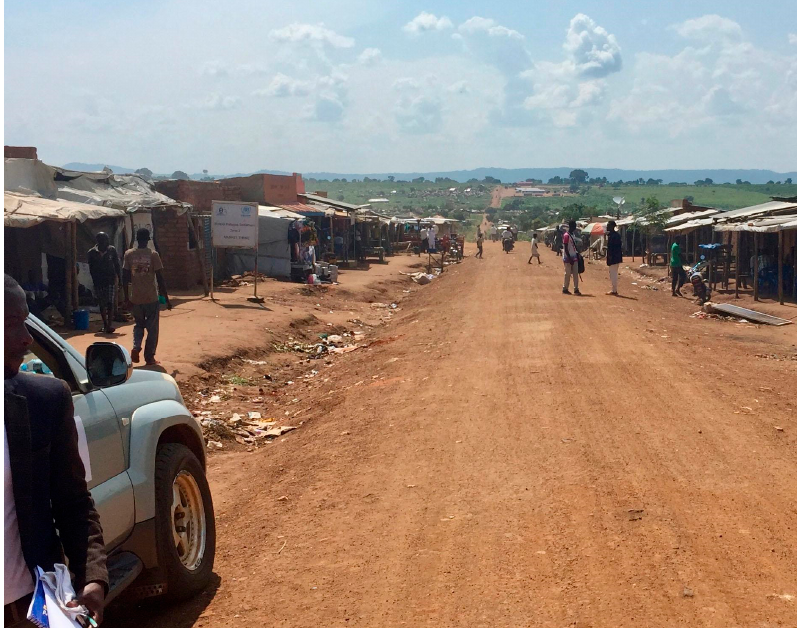
Figure 4. The market in Zone 2 is the largest market in Bidi Bidi. On this day, a national holiday, the market is quiet. Photograph taken by Tim Berke, 2019.